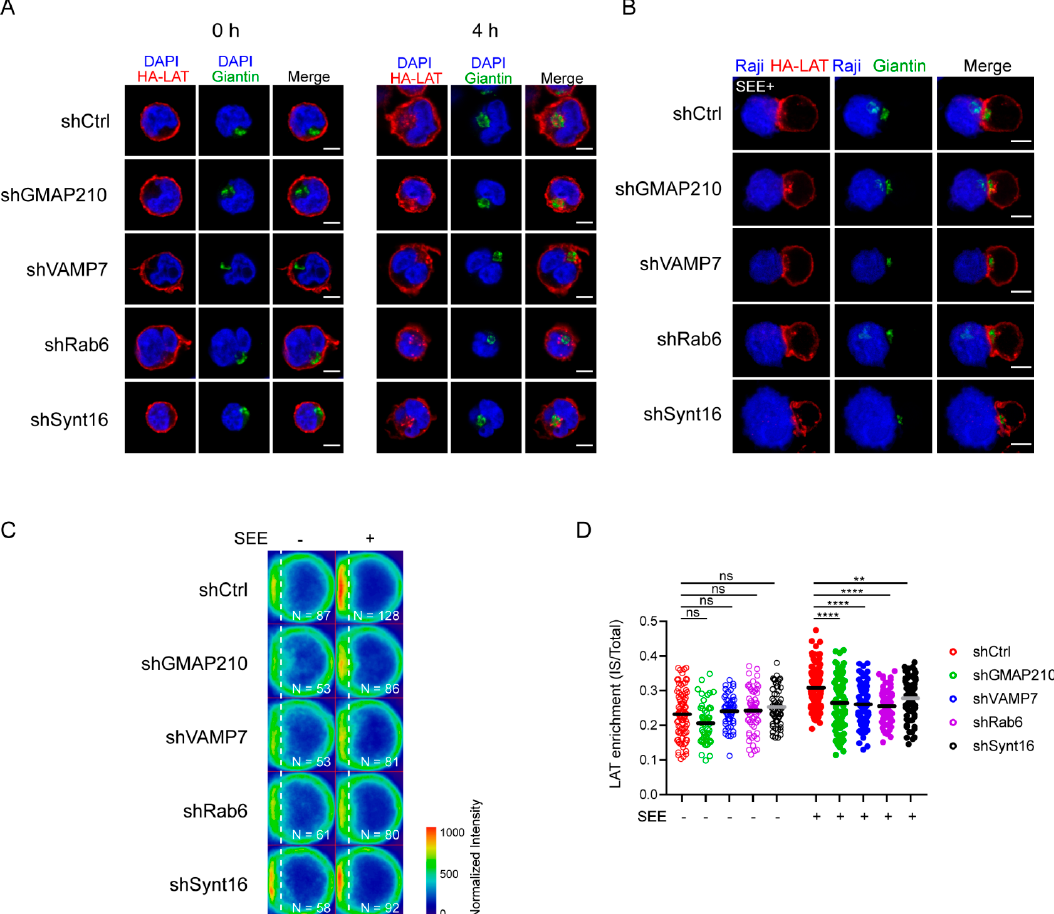
Figure 2. Retrograde and anterograde pathways regulate the recruitment of endocytic pool of LAT at the IS. ( A ) Confocal images of HA-LAT-Jurkat cells transduced with nontargeting control shRNA (shRNA Ctrl) or GMAP210/VAMP7/Rab6/Synt16-targeting shRNAs, fixed before (left panel, 0h) or after endocytosed LAT assay (right panel, 4 h) and stained for endocytosed LAT (HA-LAT, red) and the Golgi apparatus marker Giantin (green). ( B ) Confocal images of conjugates between HA-LAT-Jurkat cells (after endocytosed LAT assay) expressing control (Ctrl) or GMAP210/VAMP7/Rab6/Synt16 specific shRNA, and SEE pulsed Raji cells (blue), labeled with anti-Giantin (green) and anti-mouse 568 (red). ( C ) Average cell representation and ( D ) quanti fi cation of the enrichment of endocytosed LAT at the immune synapse (depicted by the dotted white line) in control or GMAP210/VAMP7/Rab6/Synt16 silenced cells incubated with unpulsed ( − , unactivated state) or SEE pulsed (+, immune synapse formation) Raji cells for 30 min. n = number of cells constituting the mean image. Horizontal lines represent the median. Images in ( A , B ) show the z-projection of summed slices from three stacks covering the Golgi apparatus in T cells. Scale bars = 5 µ m. Two-way ANOVA ** p < 0.01, **** p < 0.0001, ns: nonsignificant. Data and images are from two independent experiments in ( A ) and from three independent experiments ( B – D